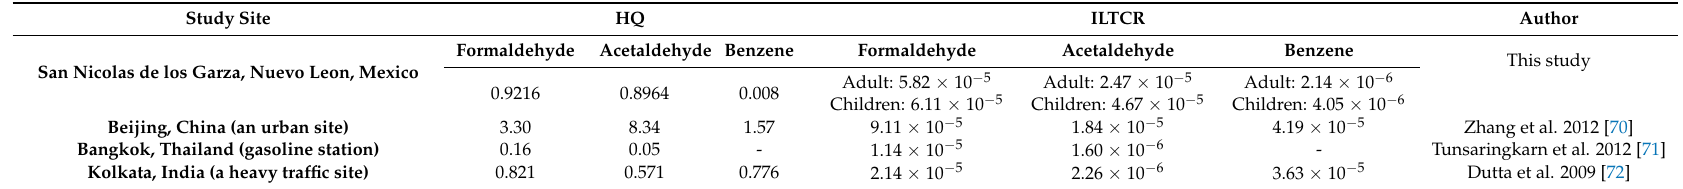
Table 10. Estimated values for associated non-cancer hazard (HQ) and cancer risk for (ILTCR) formaldehyde, acetaldehyde, and benzene found in this study and comparison with other